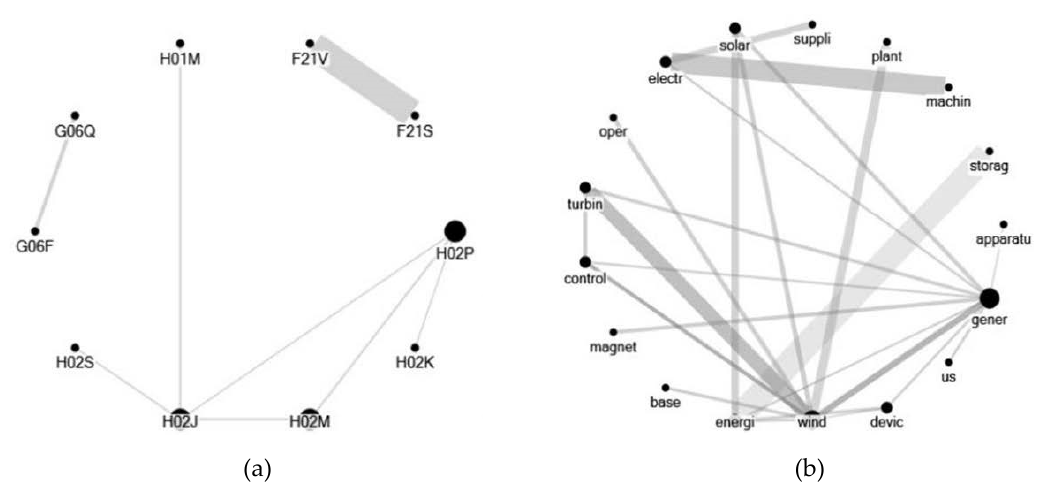
Figure 4. Electrical engineering network graph to visualize ARM. (a) Electrical engineering IPC Network; (b) Electrical engineering Key Terms Network.